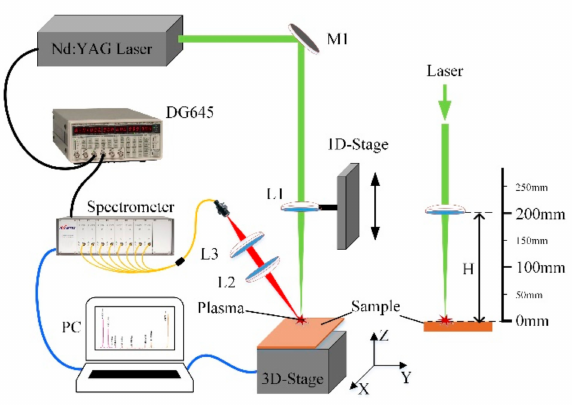
Figure 1. Schematic diagram of the laser-induced breakdown